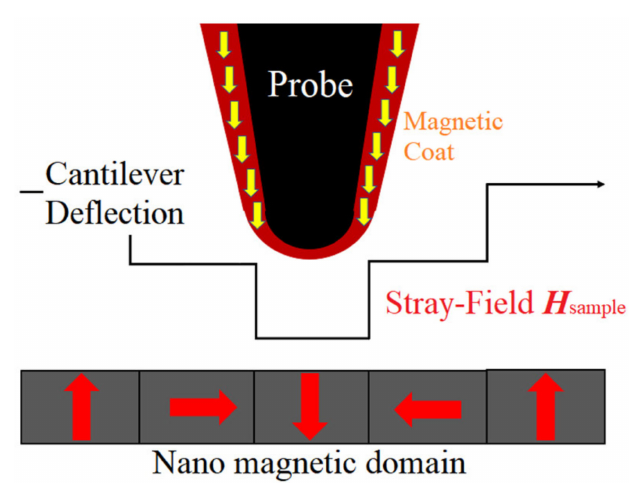
Figure 1. Schematics of magnetic force probe microscope. To reduce interference from undesired stray fields to detection signals and improve measurement accuracy, the magnetic force variation ∆ F ( z ) is used as a function of charac- terizing the magnetic domain structure as ∆ F ( z ) = F m − F pre where F m and F pre denote the detected magnetic force at distances of z and 10 nm,